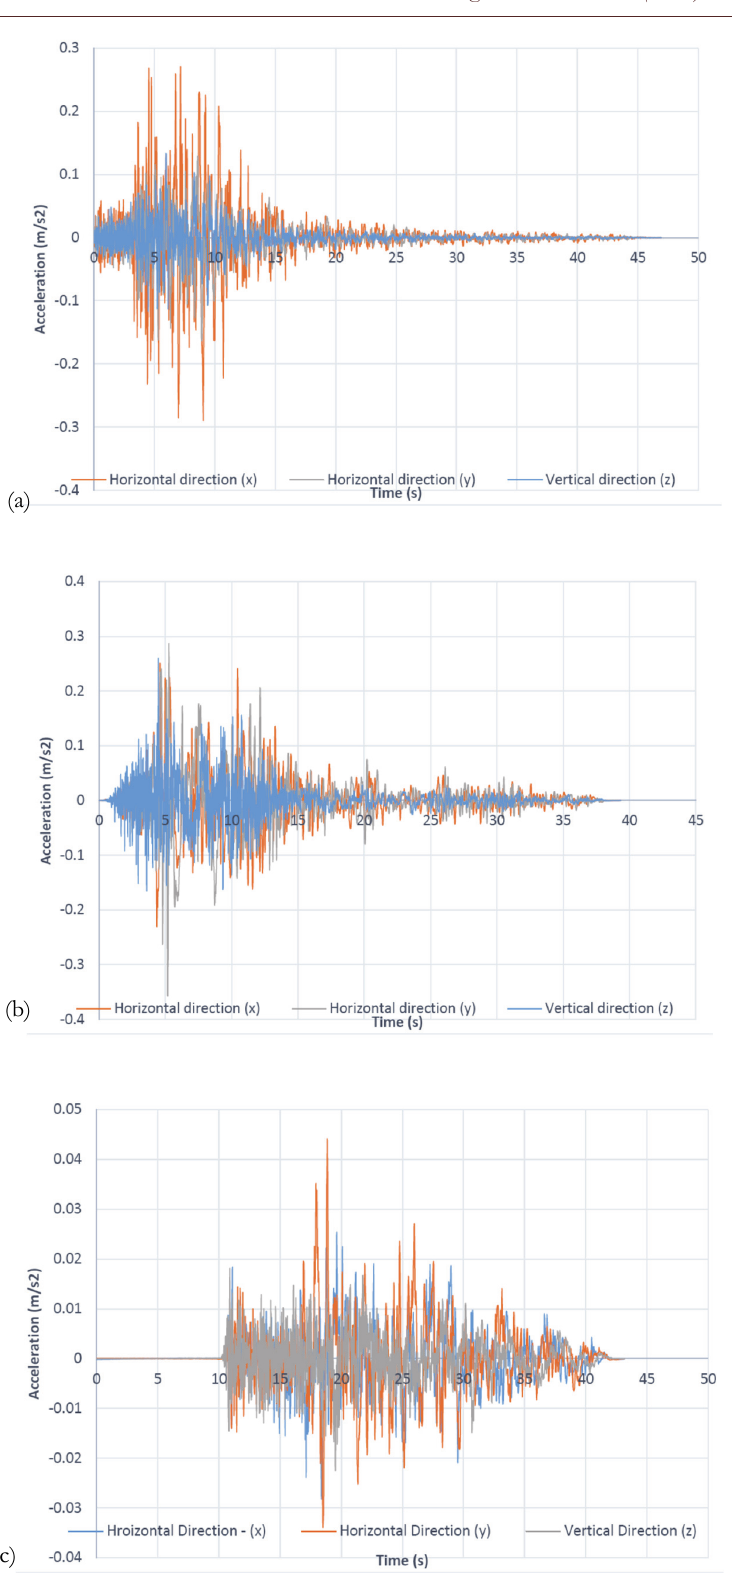
Figure 7: Ground motion records of (a) Northridge Earthquake – California, USA 1994, (b) Irpinia Earthquake – Italy 1980, (c) Düzce Earthquake – Turkey